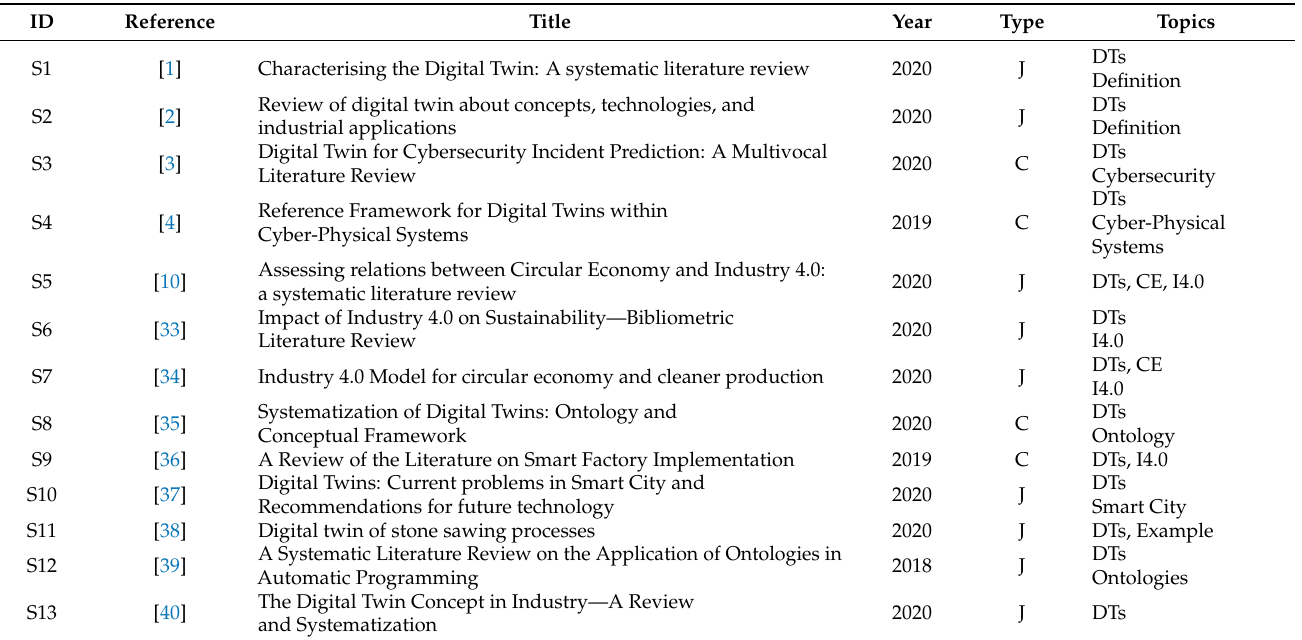
Table 2. Set of selected SLR papers.